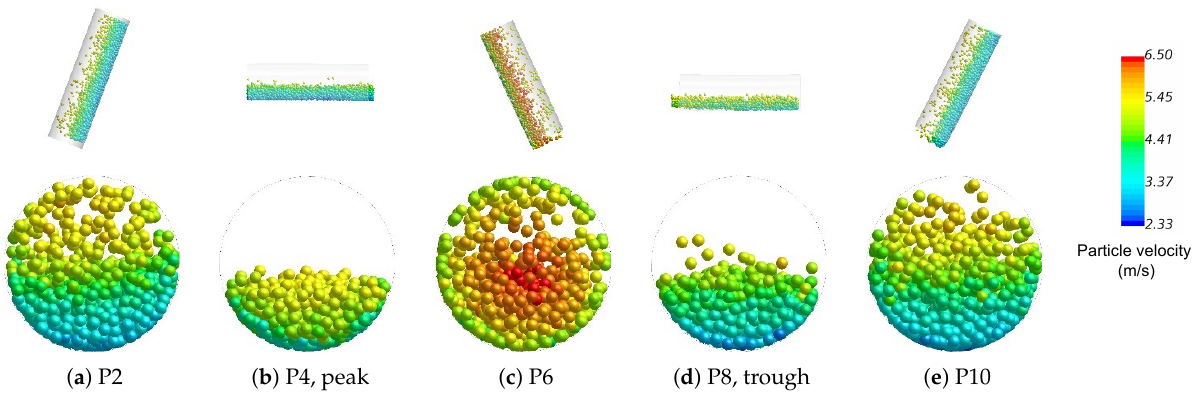
Figure 8. Particle velocity and distribution in longitudinal and cross sections of typical monitors.